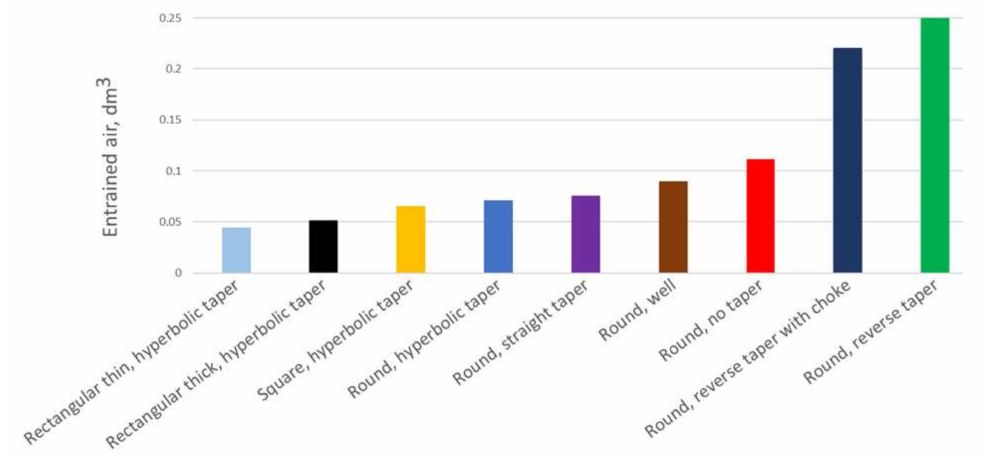
Figure 36. Air entrapment criterion for examined 500 mm sprues,